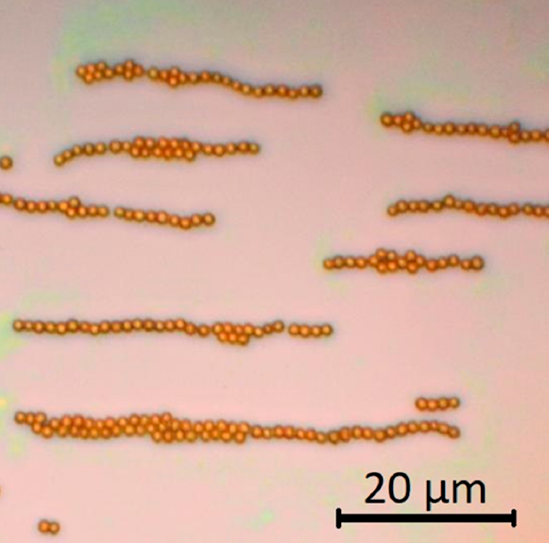
Figure 7. Line formation of 1.31 μ m diameter MSNs under in-plane applied field allocated sparsely on the substrate. The applied field is 0.11 T along the horizontal direction. This is a common behavior of MSNs when they assemble in a solid–liquid interface [17]. At lower deposition angles, like φ = 10° (Figure 8), MSNs of 536 nm diameter form large (in μ m) rectangular blocks organized along the applied magnetic field direction. Their structural coherence spans with lengths of 0.2–0.3 μ m. The “cracks” between the blocks are attributed to the evaporation of the water solvent.